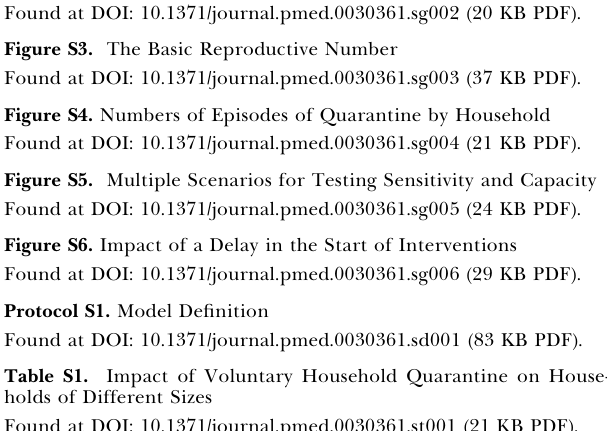
Figure S2. Household Dynamics Found at DOI: 10.1371/journal.pmed.0030361.sg002 (20 KB PDF). Figure S3. The Basic Reproductive Number Found at DOI: 10.1371/journal.pmed.0030361.sg003 (37 KB PDF). Figure S4. Numbers of Episodes of Quarantine by Household Found at DOI: 10.1371/journal.pmed.0030361.sg004 (21 KB PDF). Figure S5. Multiple Scenarios for Testing Sensitivity and Capacity Found at DOI: 10.1371/journal.pmed.0030361.sg005 (24 KB PDF). Figure S6. Impact of a Delay in the Start of Interventions Found at DOI: 10.1371/journal.pmed.0030361.sg006 (29 KB PDF). Protocol S1. Model Definition Found at DOI: 10.1371/journal.pmed.0030361.sd001 (83 KB PDF). Table S1. Impact of Voluntary Household Quarantine on House- holds of Different Sizes Found at DOI: 10.1371/journal.pmed.0030361.st001 (21 KB